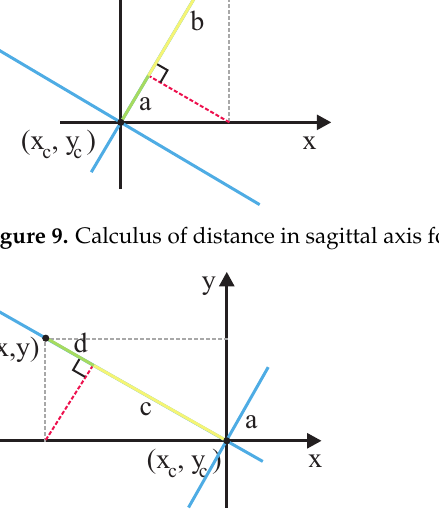
Figure 10. Calculus of distance in frontal axis for a given ( x , y ) point in the reference